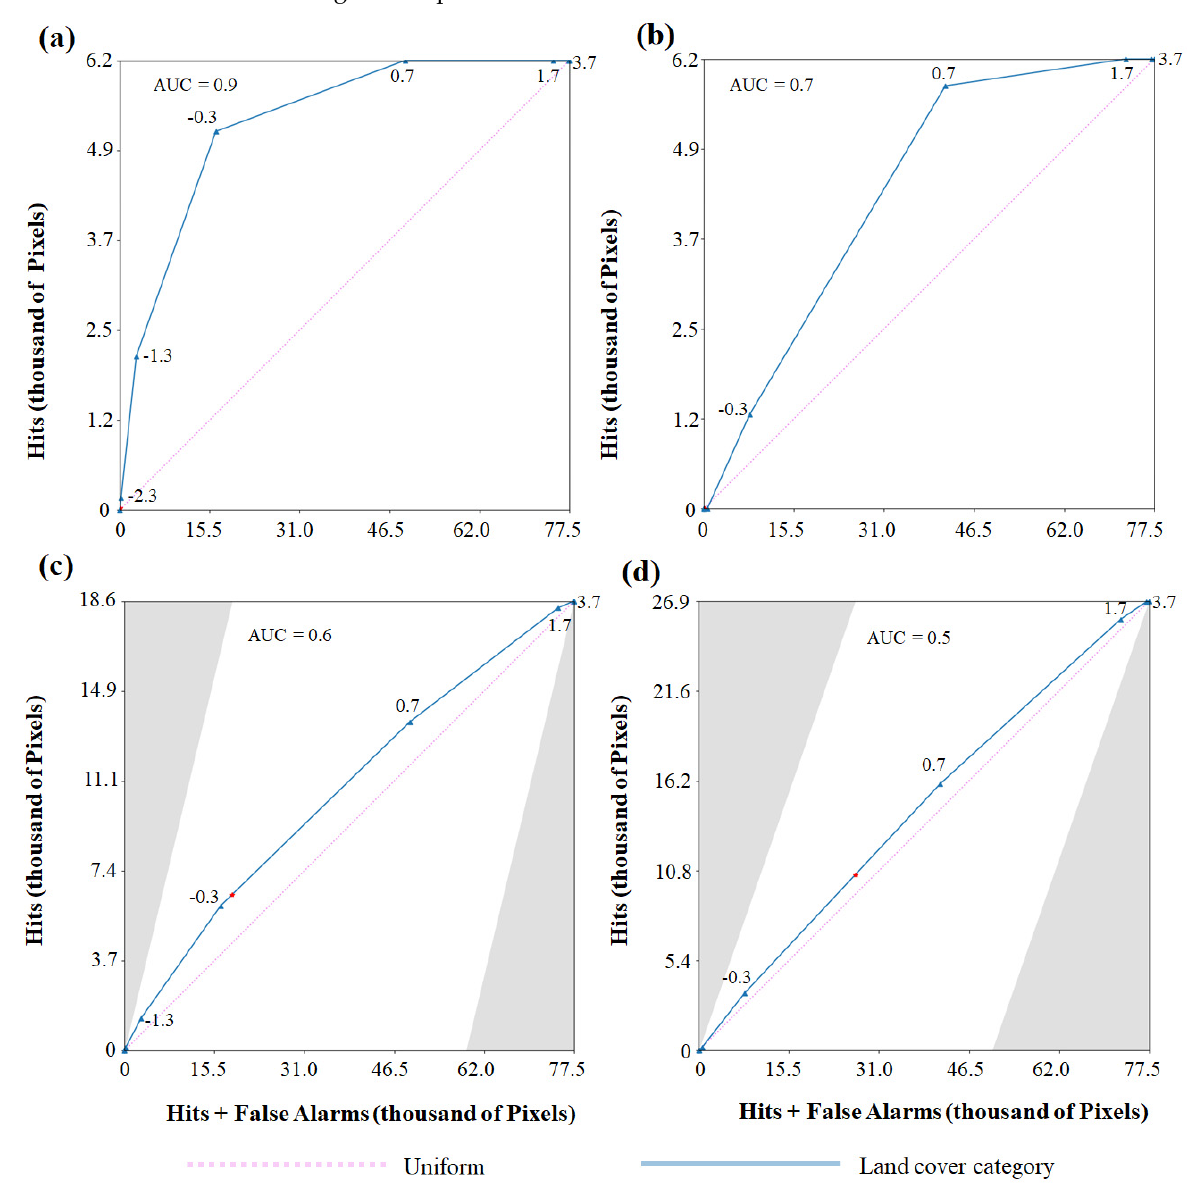
Figure 7. TOC curves for the losses of ( a , b ) Water during the first and second time intervals and ( c , d ) Bare land during the first and second time intervals.